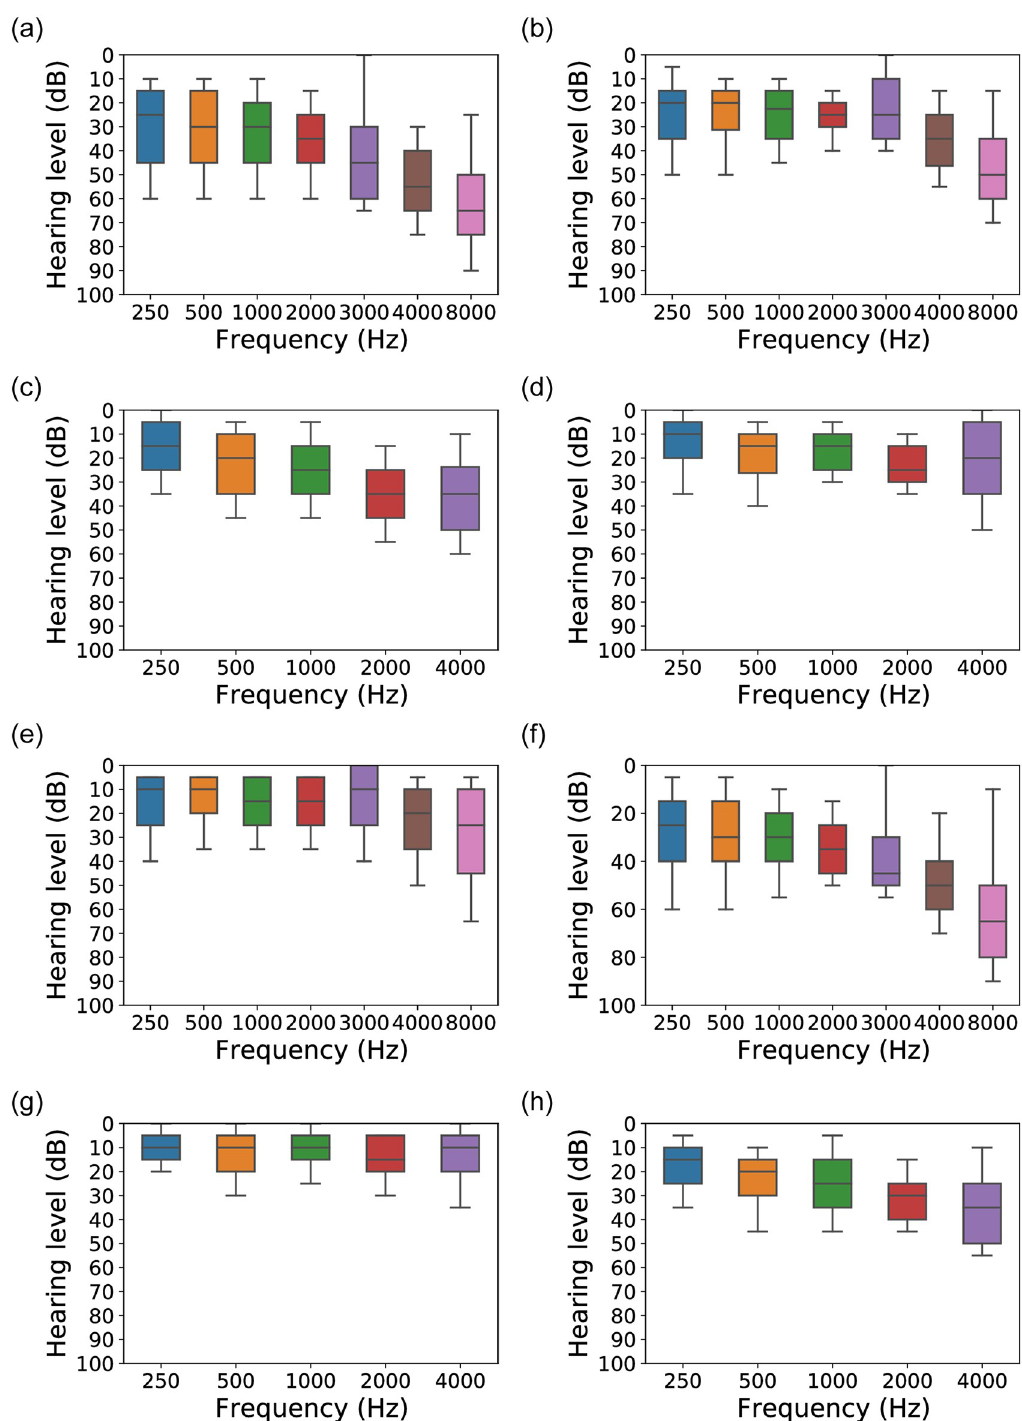
Fig 5. An average of pure tone audiograms (PTA) in all subjects’ AC and BC thresholds from 80-100 as shown in Fig 3. (a) True positive on the left AC SDS. The ‘80-89’ SDS is correctly classified as ‘80-89’. (b) False negative on the left AC SDS. The ‘80-89’ SDS is misclassified as ‘90-100’. (c) True positive on the left BC SDS. The ‘80-89’ SDS is correctly classified as ‘80-89’. (d) False negative on the left BC SDS. The ‘80-89’ SDS is misclassified as ‘90-100’. (e) True positive on the left AC SDS. The ‘90-100’ SDS is correctly classified as ‘90-100’. (f) False negative on the left AC SDS. The ‘90-100’ SDS is misclassified as ‘80-89’. (g) True positive on the left BC SDS. The ‘90-100’ SDS is correctly classified as ‘90-100’. (h) False negative on the left BC SDS. The ‘90- 100’ SDS is misclassified as